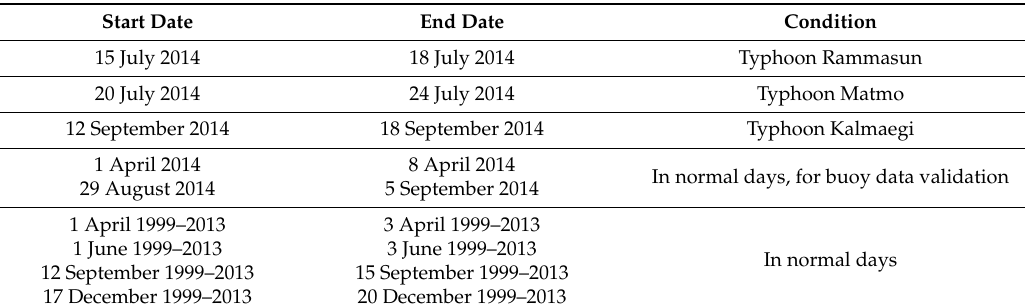
Table 1. The start and end point of the time period under typhoon conditions and non-typhoon conditions.